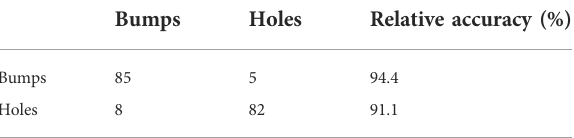
TABLE 2 Confusion matrix for shape